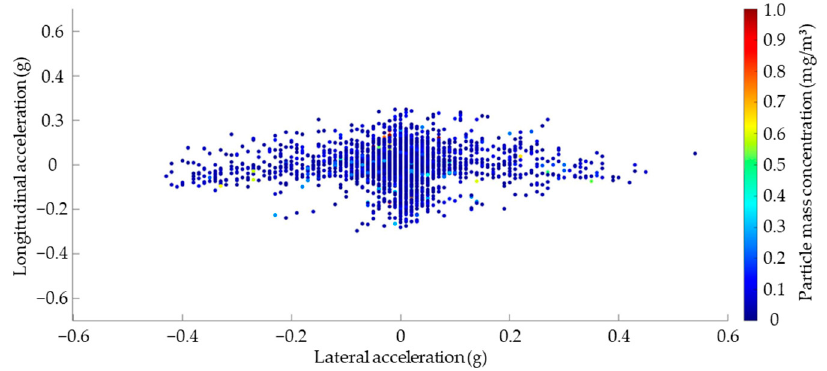
Figure 9. Correlation between longitudinal/lateral accelerations and the emission of tire wear particles–RDE test cycle.